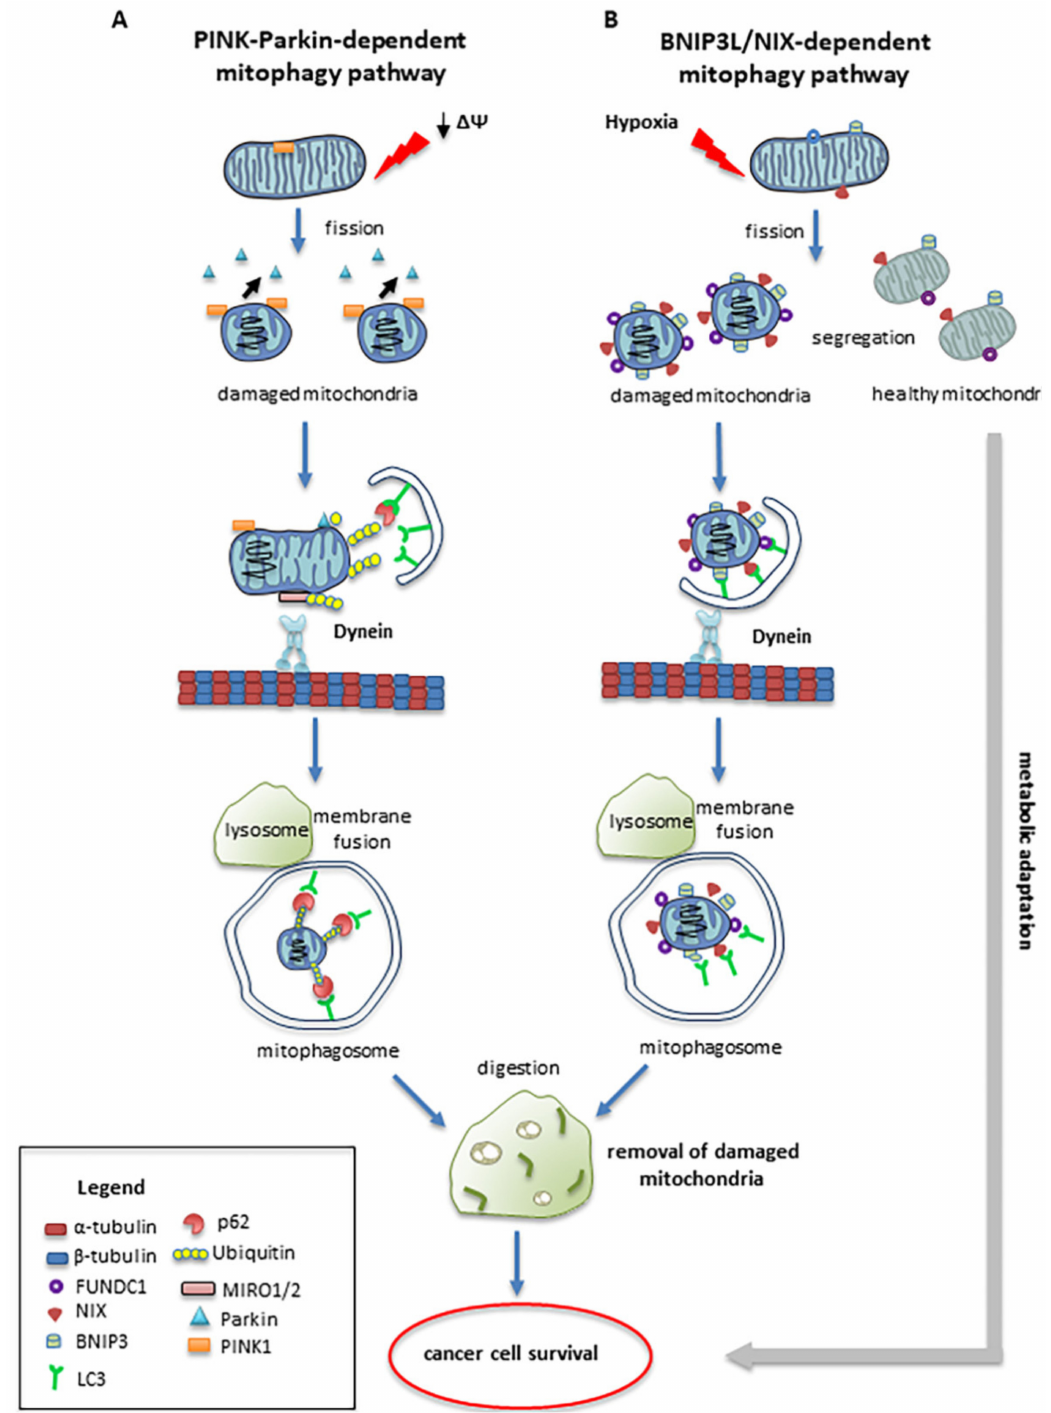
Figure 3. Mitophagy: Mitophagy is a specialized form of autophagy in which dysfunctional mitochondria are targeted and engulfed by autophagosomes that fuse with lysosomes to degrade the encapsulated mitochondria. Mitophagy is regulated by a number of different mechanisms, including Pink1/Parkin-mediated pathways and the BNIP3/NIX pathways. ( A ) When mitochondria are damaged by losing their membrane potential ( ∆Ψ ), PINK1 recruits Parkin from the cytosol to the damaged mitochondria. Here, phosphorylated Parkin ubiquitinates outer membrane mitochondrial proteins, and causes mitochondrial engulfment by binding to LC3 on the isolation membranes that fuse with lysosomes. ( B ) BNIP3/NIX-mediated mitophagic pathways are activated in cancer cells by hypoxia. Outer mitochondrial membrane proteins, such as BNIP3/NIX, bind to LC3 on the isolated membranes, mediating the sequestration of damaged mitochondria into